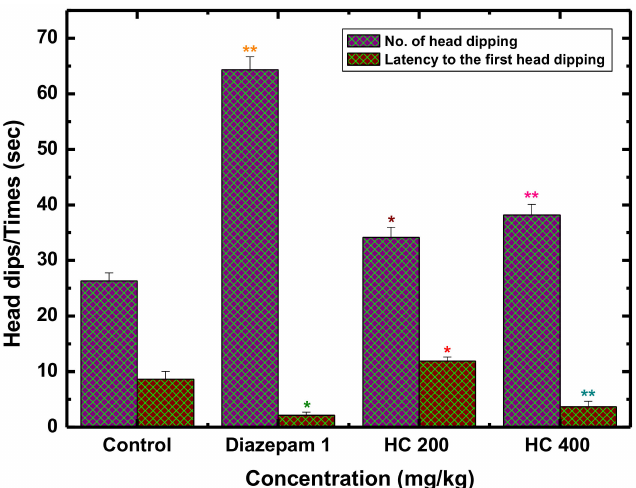
Figure 2. Anxiolytic activity of MEHC and diazepam on hole board test in mice. Values are mean ± S.E.M. (* p < 0.05) and (** p < 0.01), significantly different from control; ANOVA followed by Dunnett’s test ( n = 6, per group). MEHC: methanol extract of Holigarna caustica ; HC 200, methanol extract of H. caustica 200 mg / kg; HC 400, methanol extract of H. caustica 400 mg / kg; Reference drug diazepam 1 mg /